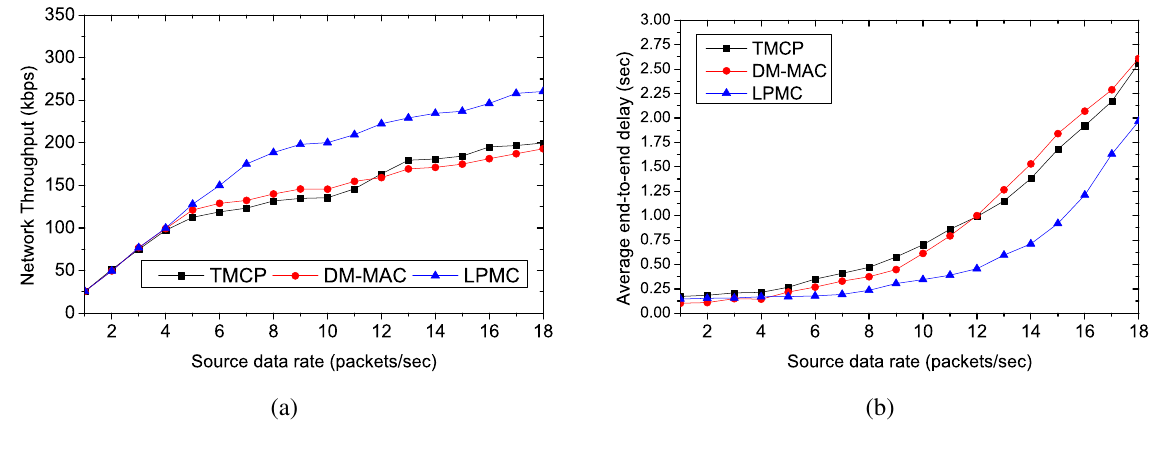
Figure 6. Performance with varying number of sources from a randomly selected location: (a) network throughput, (b) delivery